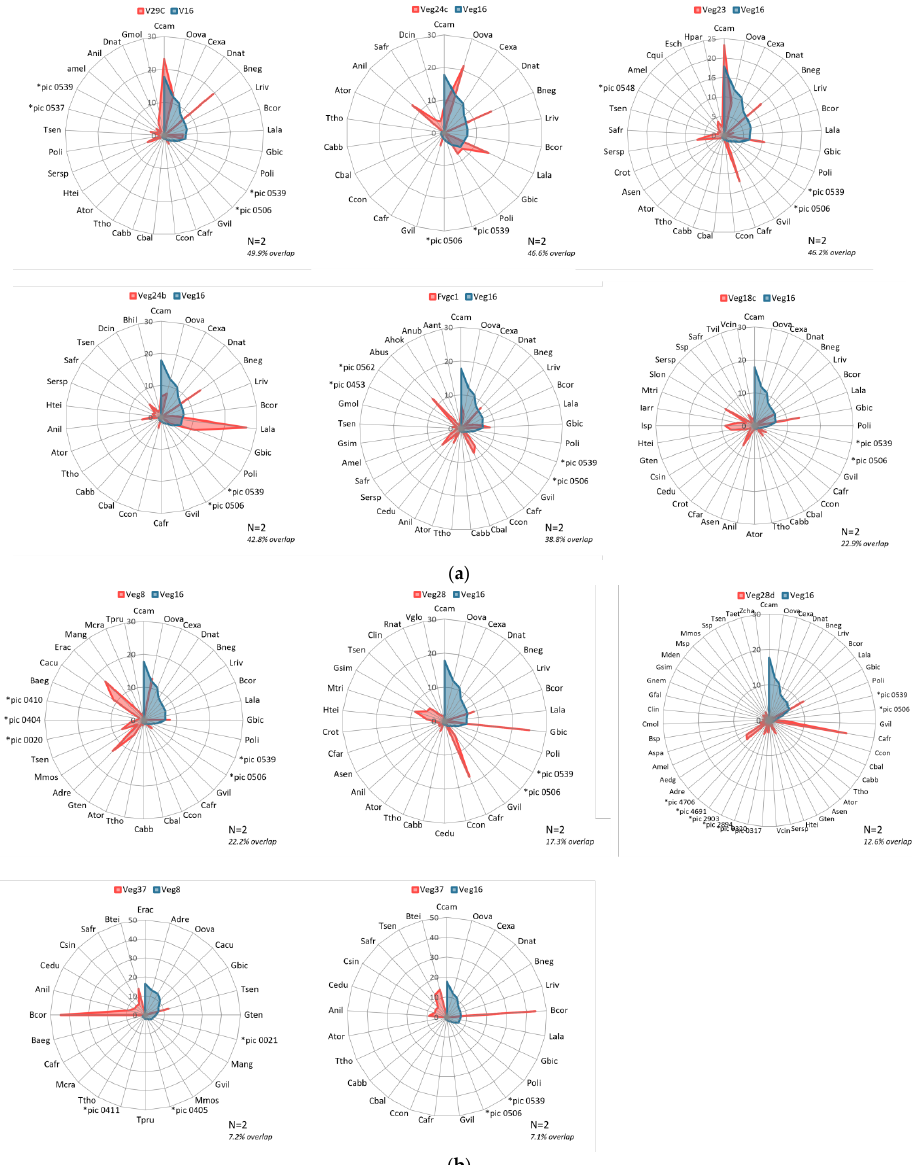
Figure 9. ( a ) Paired comparisons of vegetation species’ compositions for classification classes that returned an ROI separability metric of N = 2 in order from the pairwise comparison with the highest species’ overlap. Very high margins of overlap are represented here, and equally significant variations of species dominance as based on the position along the axis. There is a lot more of common species occurring in both of the class pairs for these comparisons, just in varying quantities, making them spectrally distinguishable. The ‘*pic no.’ are unidentified species as by the end of this study (Figure A1). See Appendix A Table A1 for abbreviated species’ names meanings. Unknown species were assigned labels starting with *pic and are shown in Figure A1. ( b ) A continuation of Figure 9a showing the species compositions of pairwise comparisons and the species’ overlap. All but one of the graphs is a comparison between Veg16 classification class and other classes whose identification pixels all were determined to be spectrally separable. The central axes represent the RIV values and show how contributing species vary in position of dominance. As the percentage overlap reduces, we see considerable differences in species’ compositions, with there being more species limited to either of the class pairs. See Appendix A Table A1 for abbreviated species’ names meaning. Unknown species were assigned labels starting with *pic and are shown in Figure